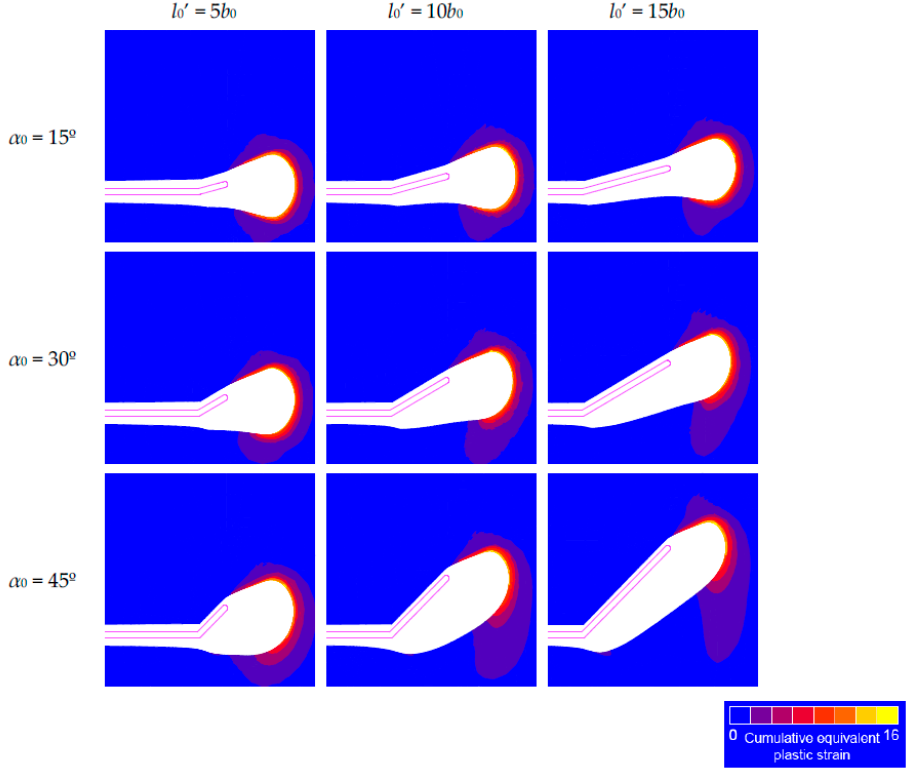
Figure 8. Initial and deformed crack tips after 20 cycles (with the cumulative equivalent plastic strain in color) for the kinked crack tip with Δ K = 50 MPam 1/2 .